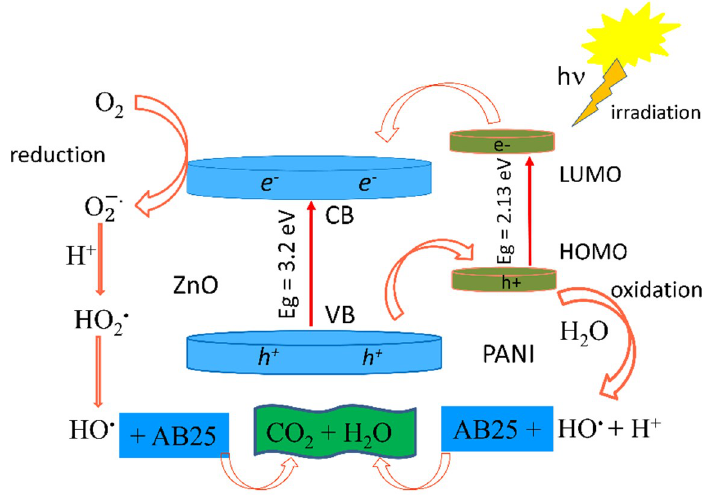
Scheme 3. Proposed photocatalytic degradation mechanism of AB25 using PANI/ZnO composites. CB, conducting band; VB, valence band; LUMO, lowest unoccupied molecular orbital; HOMO,